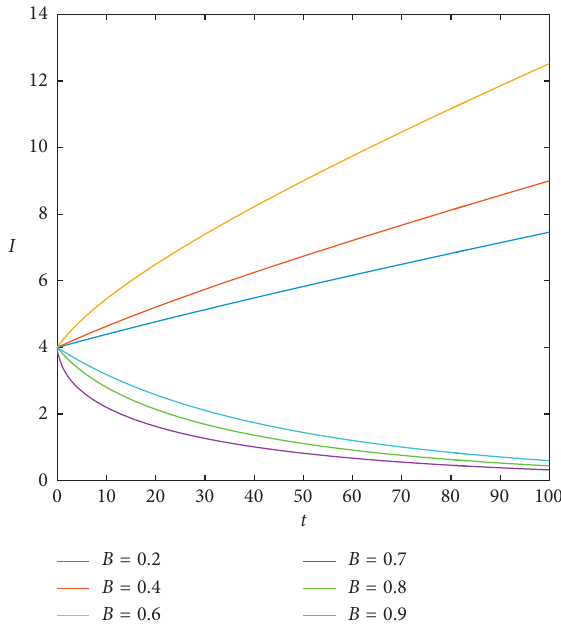
Figure 1: Abatement levels under different B ( t )